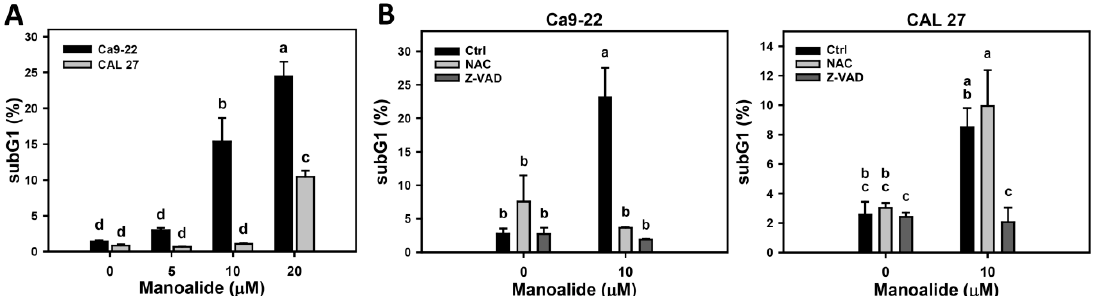
Figure 2. Cell cycle changes of manoalide-treated oral cancer (Ca9-22 and CAL 27) cells. ( A ) Statistical results of the subG1 (%) for manoalide-treated oral cancer cells in Figure S2A. Cells were treated with 0, 5, 10, and 20 μ M of manoalide for 24 h. ( B ) Statistical result of the subG1 (%) for NAC, Z-VAD, and/or manoalide-treated oral cancer cells in Figure S2B. Cells were pretreated with 8 mM, 1 h for NAC or 100 μ M and 2 h for Z-VAD, and they were then post-incubated with 10 μ M of manoalide for 24 h. Data, means ± SDs ( n = 3). Data were analyzed by one-way ANOVA with Tukey HSD Post Hoc Test. Data showing no overlapping same small letters represent significant difference ( p < 0.05–0.001).